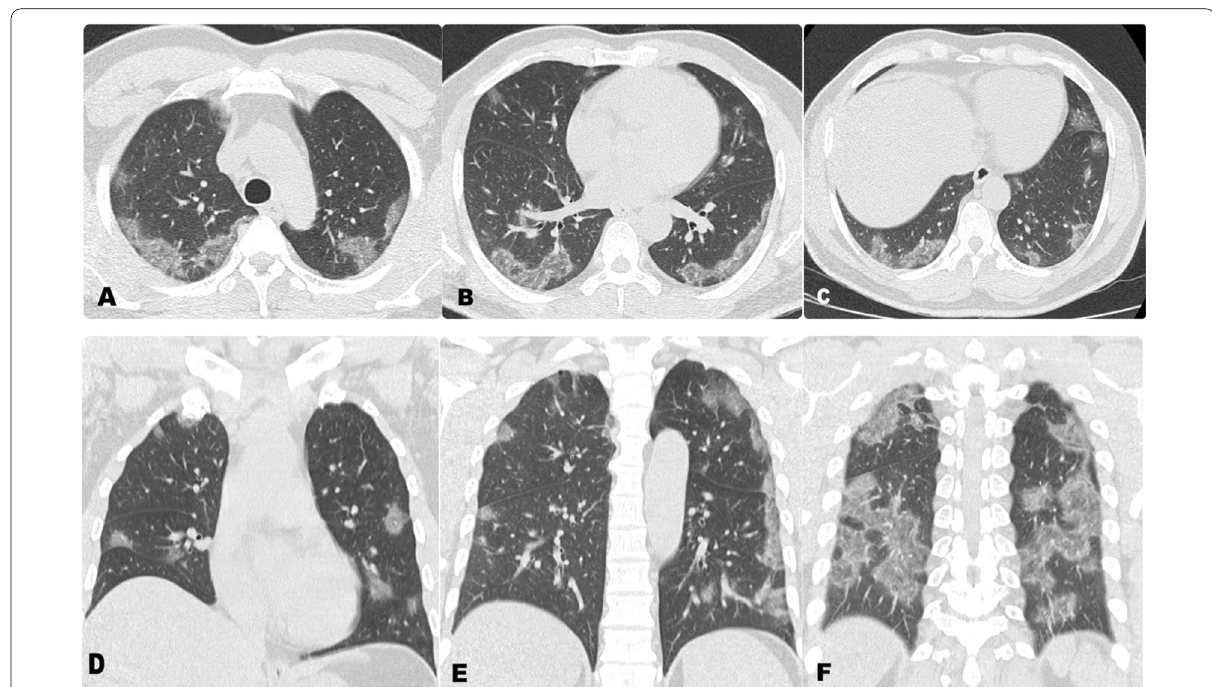
Fig. 2 A – C Axial and D – F reformatted coronal non‑contrast CT chest of a 53‑year‑old male patient with positive RT‑PCR for Covid‑19, show bilateral scattered ground‑glass opacities with a primarily peripheral distribution. CT severity score is 15 points which corresponds to moderate